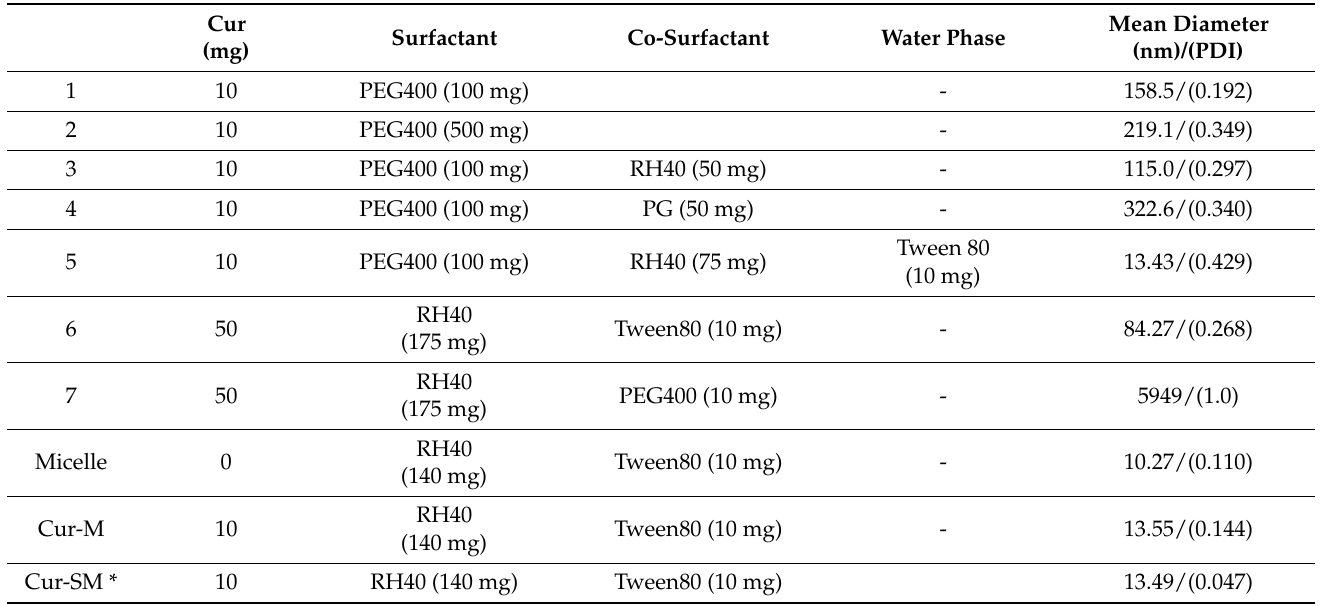
Table 1. Compositions and physical characterizations of micelle formulations. Micelle: void vector of the OFSAS (oil-free self-assembly systems); Cur-M: curcumin-loaded self-assembled micelle.